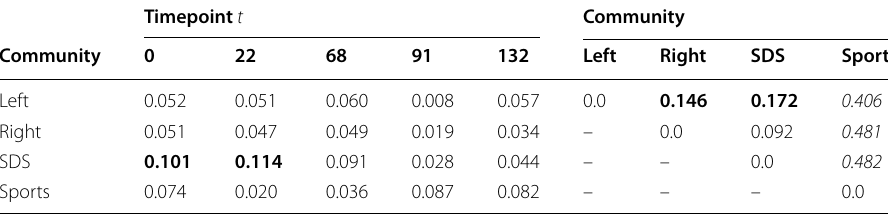
The left-hand side of the table shows the JS distances for each community C , between its cumulative distribution C ∪ and individual timepoints C t , JS ( C t � C ∪ ) . The right-hand side is a symmetrical matrix, with the JS distances between the cumulative distributions for all pairs i , j of communities, JS ( Ci ∪ � Cj ∪ ) . In bold are the JS distances 0.1 < JS ≤ 0.4 , and in italics 0.4 <